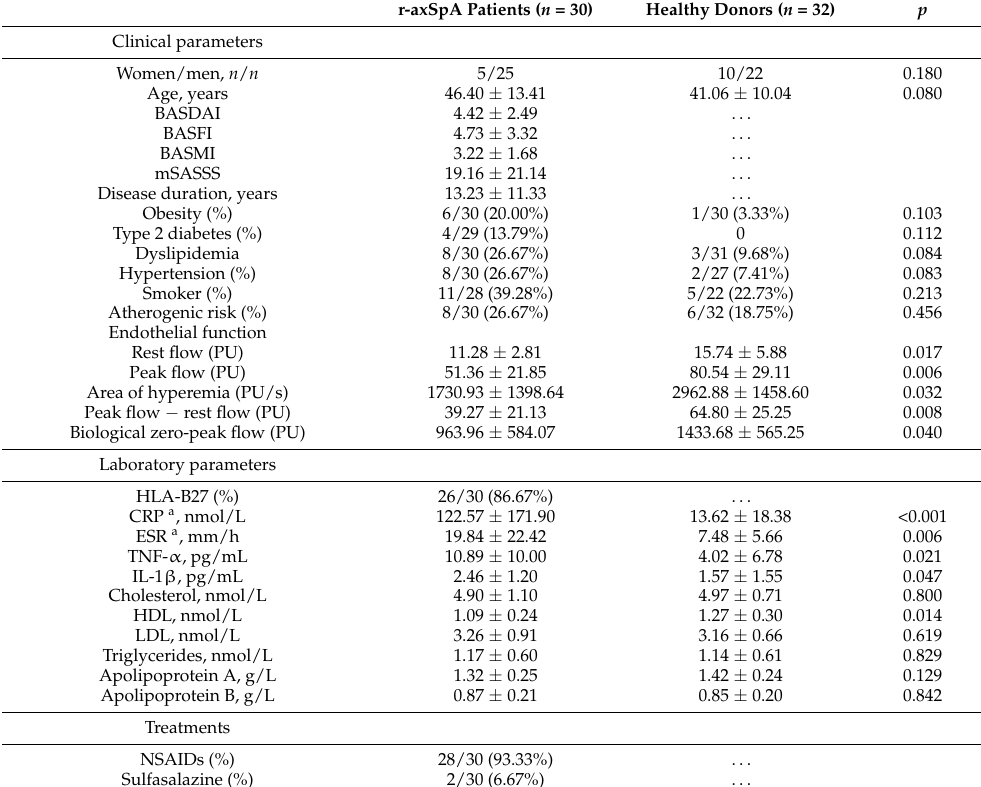
Table 1. Clinical and laboratory parameters of the radiographic axial spondyloarthritis patients and the healthy